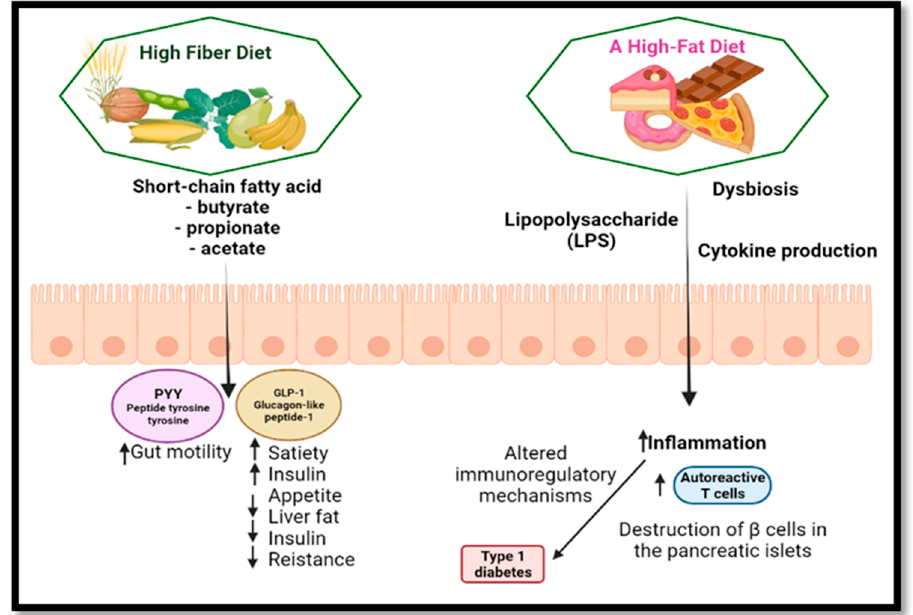
Figure 5. The consequences of a high-fiber diet vs. a high-fat diet. Created with